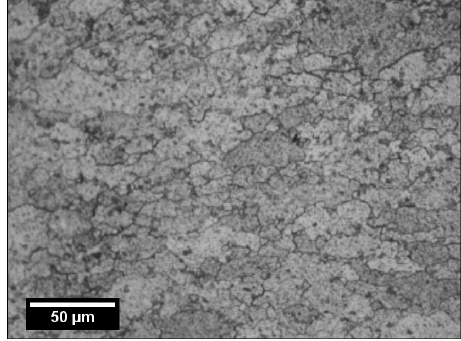
Figure 6. Microstructure of the base material.